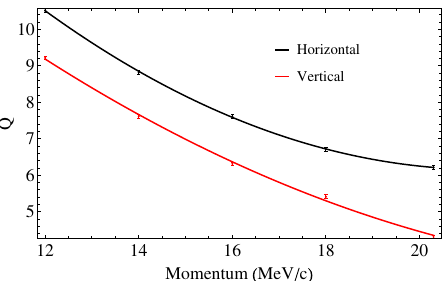
FIG. 1. Measured betatron tune versus momentum in